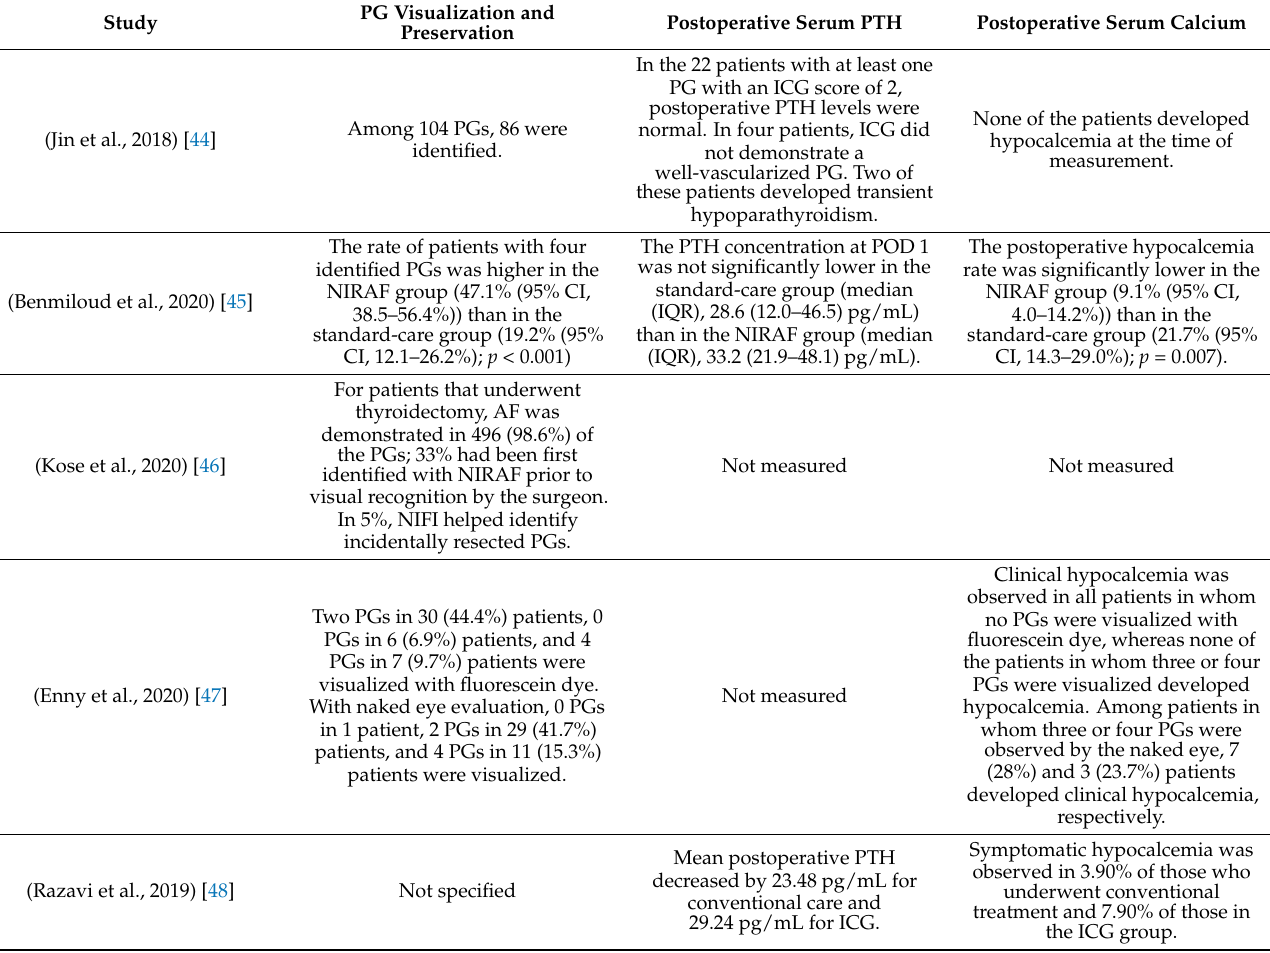
Table 4. Parathyroid gland visualization and preservation, postoperative serum parathyroid hormone levels, and postoper- ative serum calcium